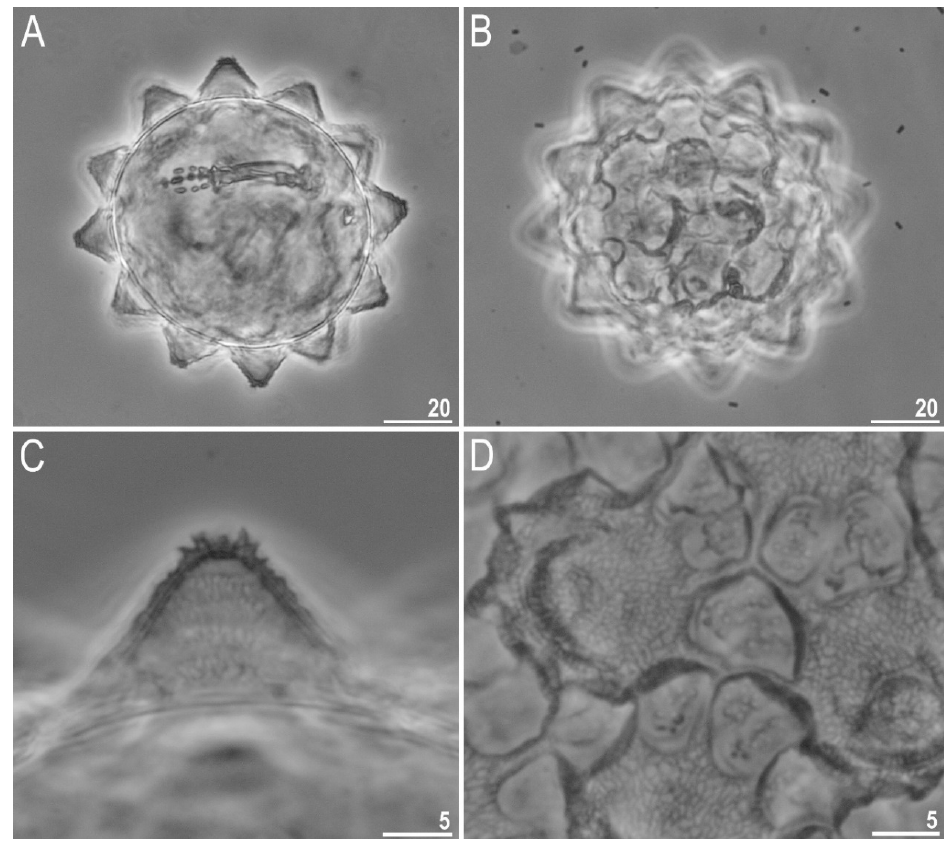
Figure 3. Paramacrobiotus fairbanksi (Polish population). ( A – B) Egg chorion; ( C) Egg process morphology; ( D) The surface between egg processes with visible areoles. Scale bars in ( μ m). All PCM. Table 2. Species list with their localities and remarks (exuvia not included; s/s + e, samples no/no specimens + eggs.